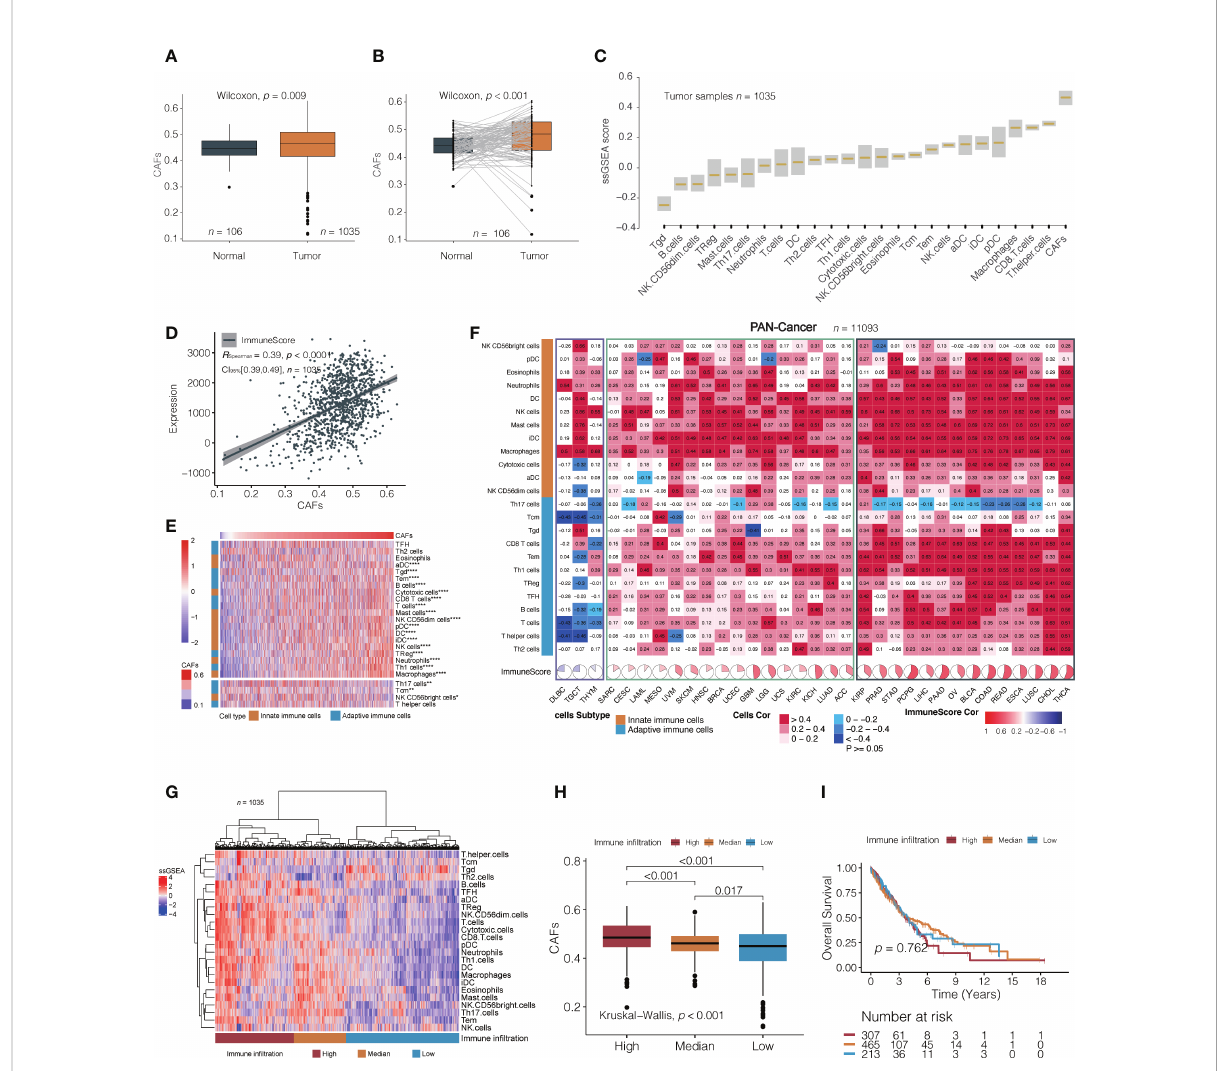
FIGURE 2 A correlation between cancer-associated fi broblasts (CAFs) and immune cells. (A, B) Analysis of TCGA NSCLC cohorts found that cancer- associated fi broblasts (CAFs) were signi fi cantly higher in tumor tissues than in normal (median value; A: 0. 460 vs. 0. 441; B: 0.484 vs. 0.441). (C) The relative amounts of CAFs and different immune cell types in TCGA NSCLC cohort. The lower and upper bounds of the box in a boxplot indicate the fi rst and third quartiles, respectively. Cell types are ordered by their median ssGSEA scores. (D) A correlation between CAFs and immune score in TCGA NSCLC cohorts. (E) The non-clustering heat map is arranged according to the correlation coef fi cient between CAF and 24 types of immune cells in TCGA NSCLC cohorts; Spearman ’ s test. The colors from red to blue denote their correlation coef fi cients of the immune score and CAFs from high to low. The top part indicates immune cells positively correlated with the content of fi broblasts, and the bottom part shows negative correlations. *, p < 0.05; **, p < 0.01; ****, p < 0.001. (F) The correlation between CAFs and 24 immune cells in 33 independent pan-cancer cohorts, clustering tumor types from left to right according to the correlation coef fi cient between CAFs and immune score. The black box indicates a positive correlation between CAFs with most immune cells, the yellow box indicates a positive correlation between CAFs with most innate immune cells, and the blue box indicates a negative correlation between CAFs and distinct immune cells. (G) CAF difference analysis between high, medium, and low tumors with immune in fi ltration in TCGA NSCLC cohorts. The clusters were generated using unsupervised K-means clustering. (H, I) Differences in CAFs (median value; high, 0.485; median, 0.461; low, 0.449) and overall survival (median value; high, 3.66, median, 3.89; low, 3.98) among the three immune in fi ltration levels were analyzed in TCGA NSCLC